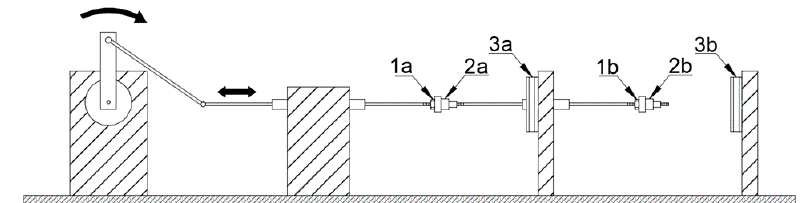
Figure 2. The schematic structure of the experimental setup for testing cuffs at a temperature range from 4 °C to 20 °C (Elements for setting oscillation amplitude: 1a/1b—contra thread 2a/2b—body for fastening of a smaller diameter of a cuff, 3a/3b—body for fastening of a bigger diameter of a cuff).